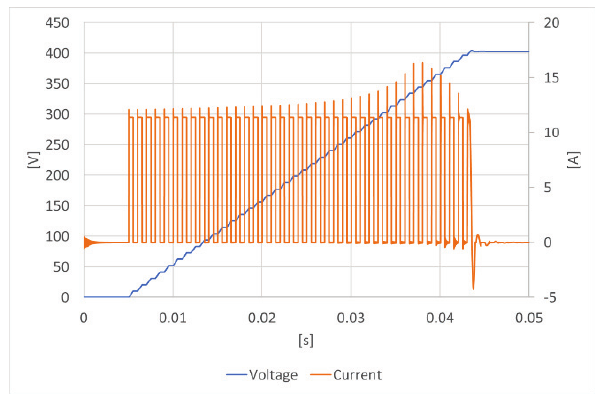
Fig. 5. PWM method DC-Link capacitance